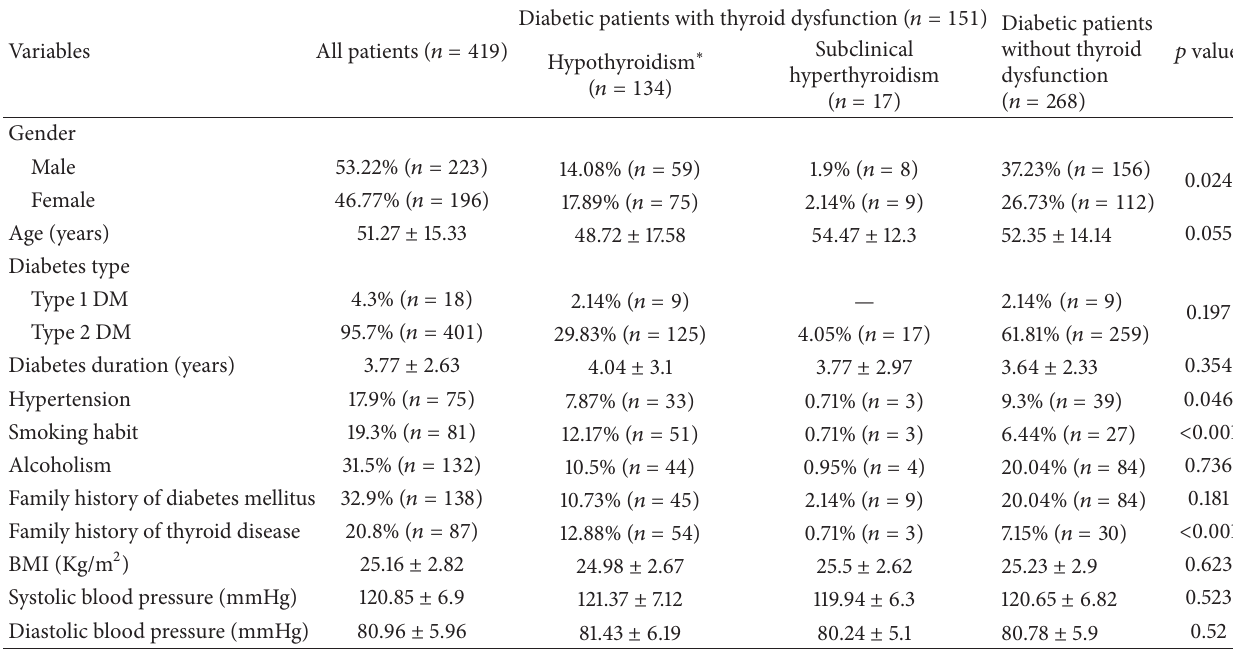
Table 1: General characteristics of the study population.